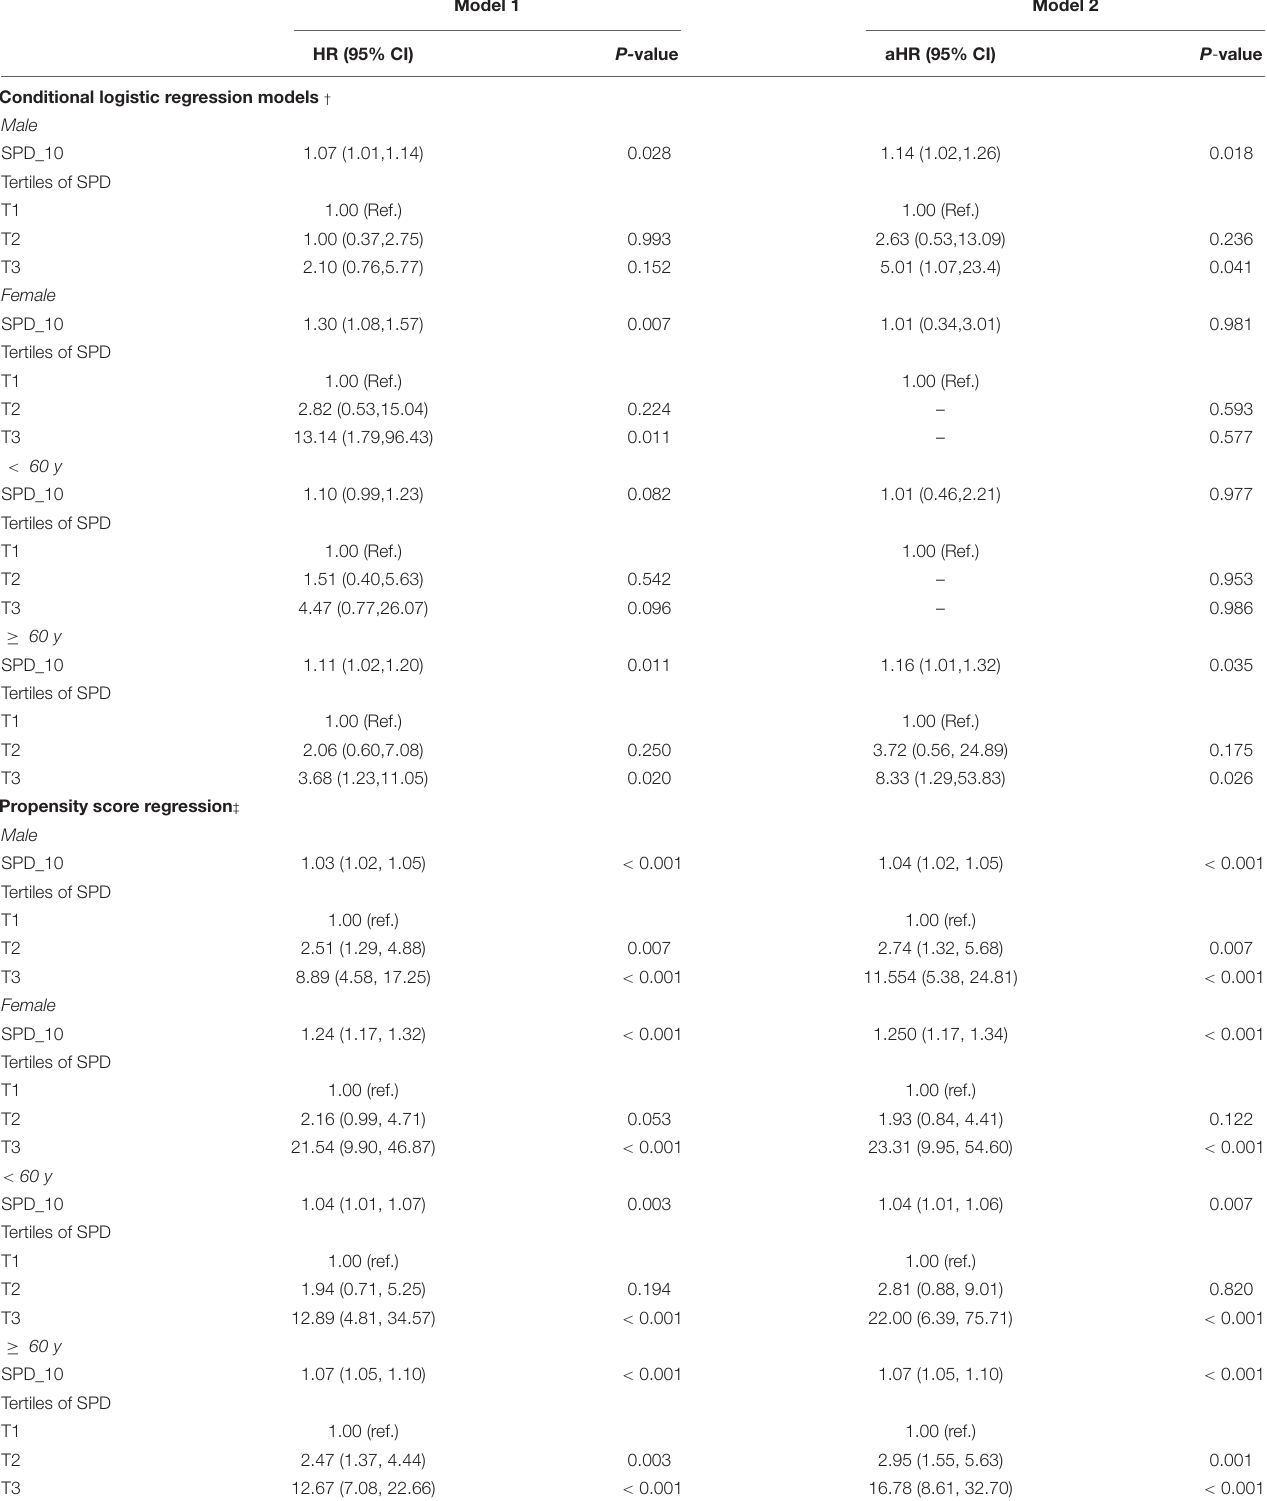
TABLE 3 | Relationship between serum spermidine levels and stroke risk stratified by sex/age groups in prospective and retrospective case-control